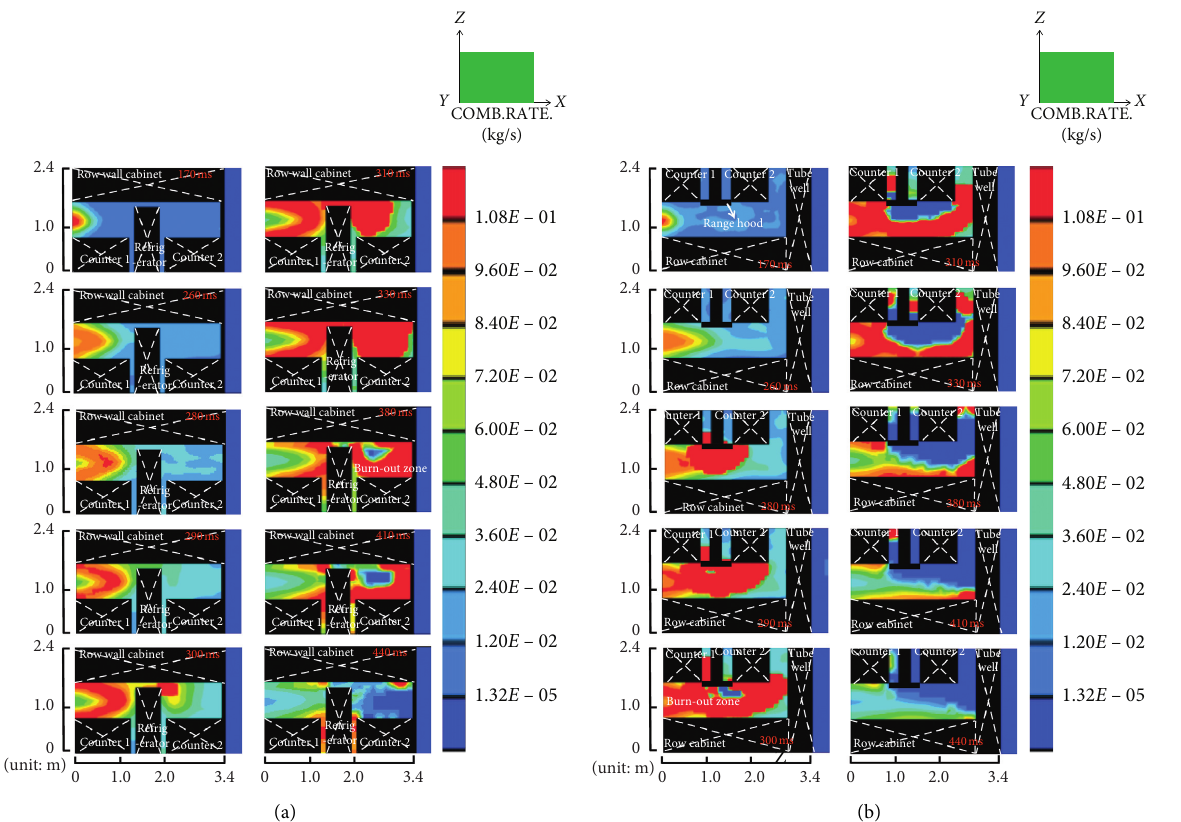
Figure 10: The flame expansion cloud diagram on the two paths y � 1.8m and y � 0.3m after ignition. (a) y � 1.8m.(b) y �